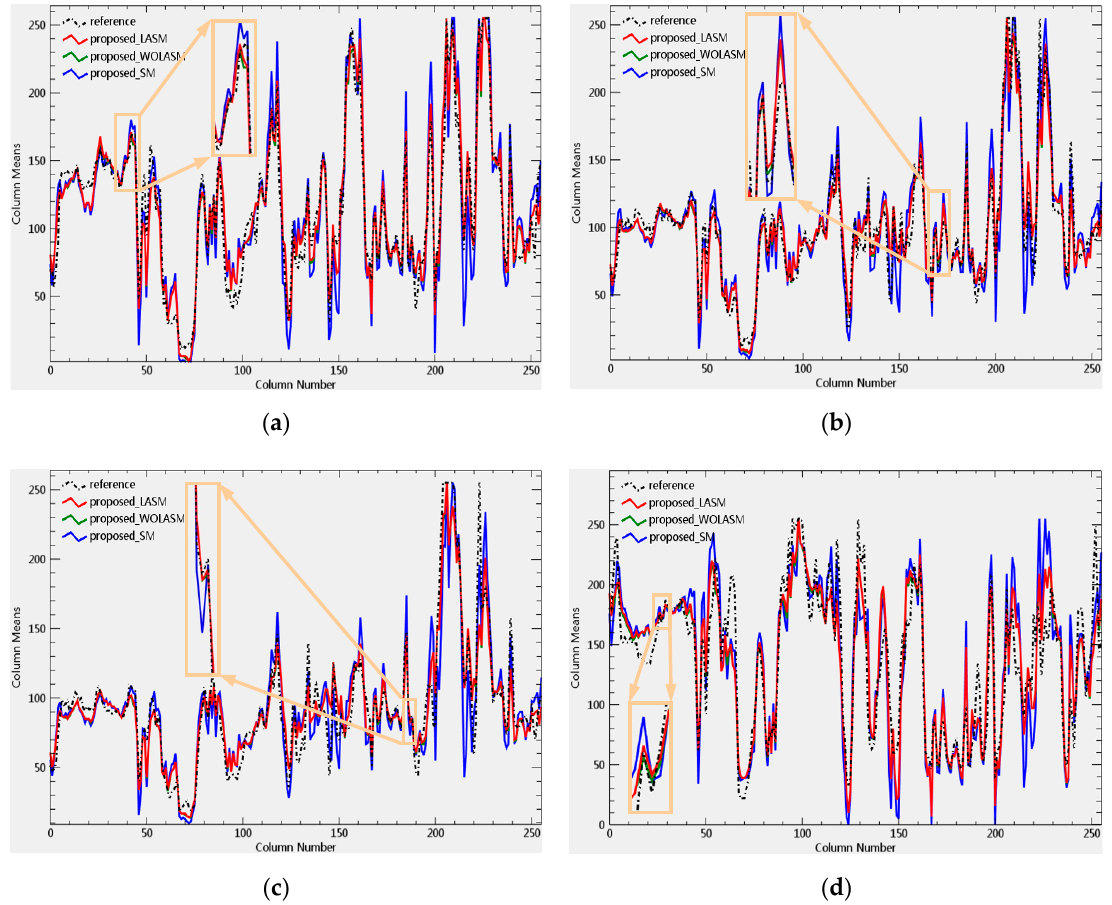
Figure 2. Horizontal spectral profiles of fusion results for test results in Figure 1: ( a ) Red band; ( b ) Green band; ( c ) Blue band; and ( d ) near-infrared (NIR) band. WOLASM, without LASM.